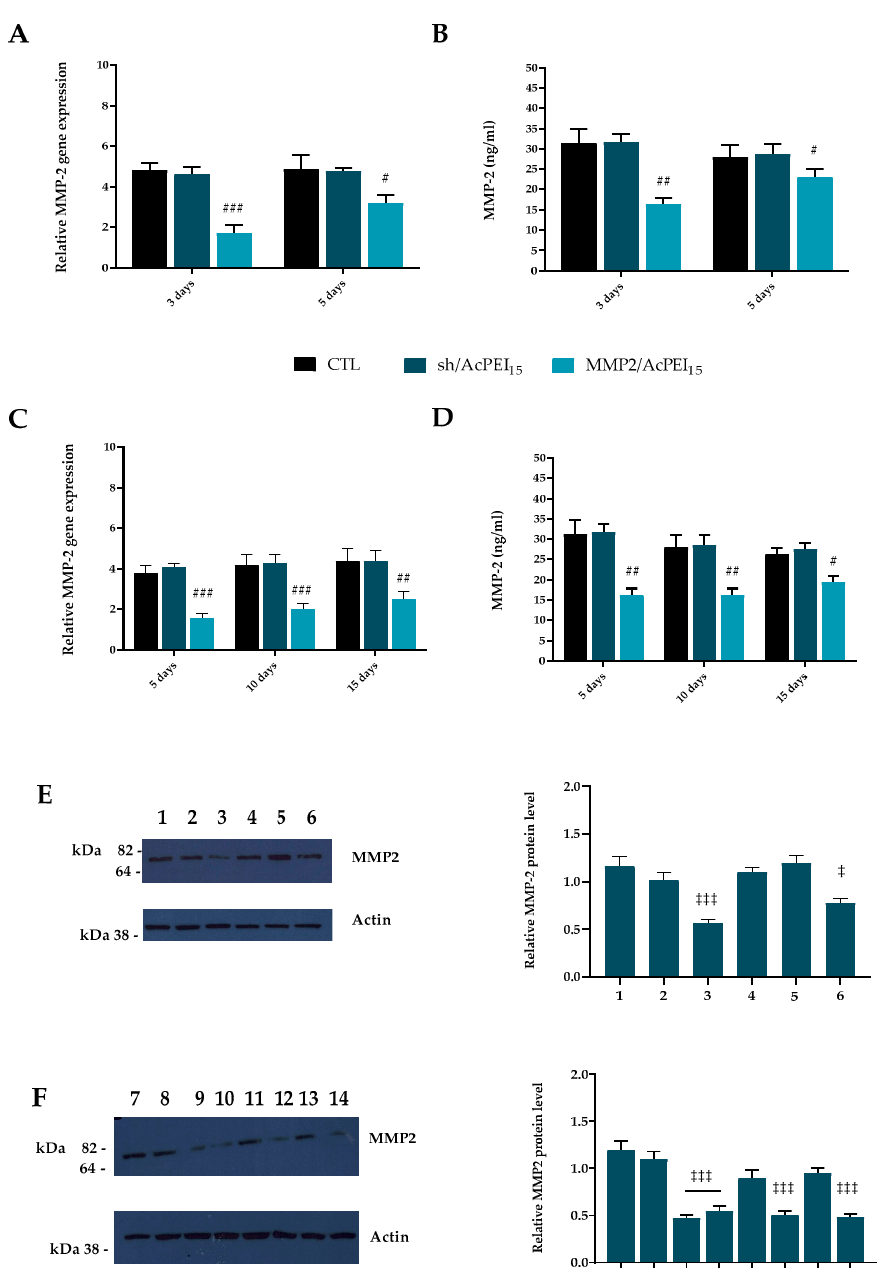
Figure 4. ( A , C ) Quantitative RT-PCR analysis of matrix metalloproteinase 2 ( MMP-2 ) gene expression in PC3 cells cultured for 3, and 5 days in presence of MMP2/AcPEI 15 or sh/AcPEI 15 . Non-transfected cells are used as control (CTL). The target gene expression was normalized to the housekeeping genes HPRT1 and GAPDH . Relative differences in the PCR results were calculated using the comparative CT (2 −ΔΔ Ct ) method. ( B ) ELISA assay of MMP-2 in conditioned medium of PC3 treated with MMP2/AcPEI 15 or sh/AcPEI 15 for 3 and 5 days and in ( D ) for 5, 10 and 15 days. Non-transfected cells are used as control (CTL). ( E , F ) Western blot analysis of MMP2 protein was performed on total C20A4 protein fraction. ( E ) (1: CTL, 2: sh/AcPEI 15, 3: MMP2/AcPEI 15) ) 3 days; (4: CTL, 5: sh/AcPEI 15 , 6: MMP2/AcPEI 15 ) 5 days. ( F ) 7: CTL, 8: sh/AcPEI 15 , 9: MMP2/AcPEI 15 3 days, 10: MMP2/AcPEI 15 5 days, 11: sh/AcPEI 15 , 12: MMP2/AcPEI 15 10 days, 13: sh/AcPEI 15 , 14: MMP2/AcPEI 15 15 days. The protein expression was normalized to the housekeeping protein Actin. The bars represent the means ± standard deviation (n = 3). # p < 0.05, ## p < 0.01 and ### p < 0.001 versus CTL and sh/AcPEI 15